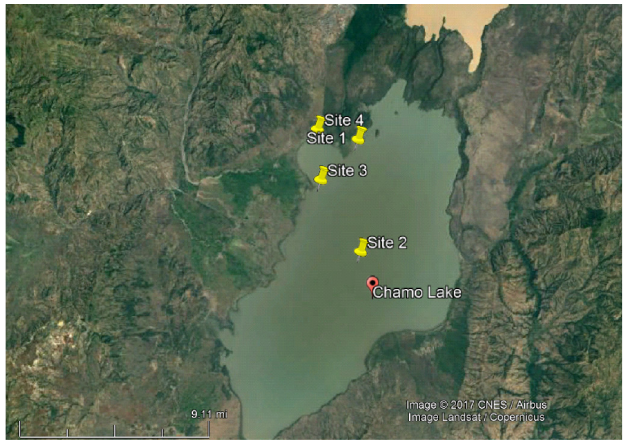
Fig. 1. Study area and sampling